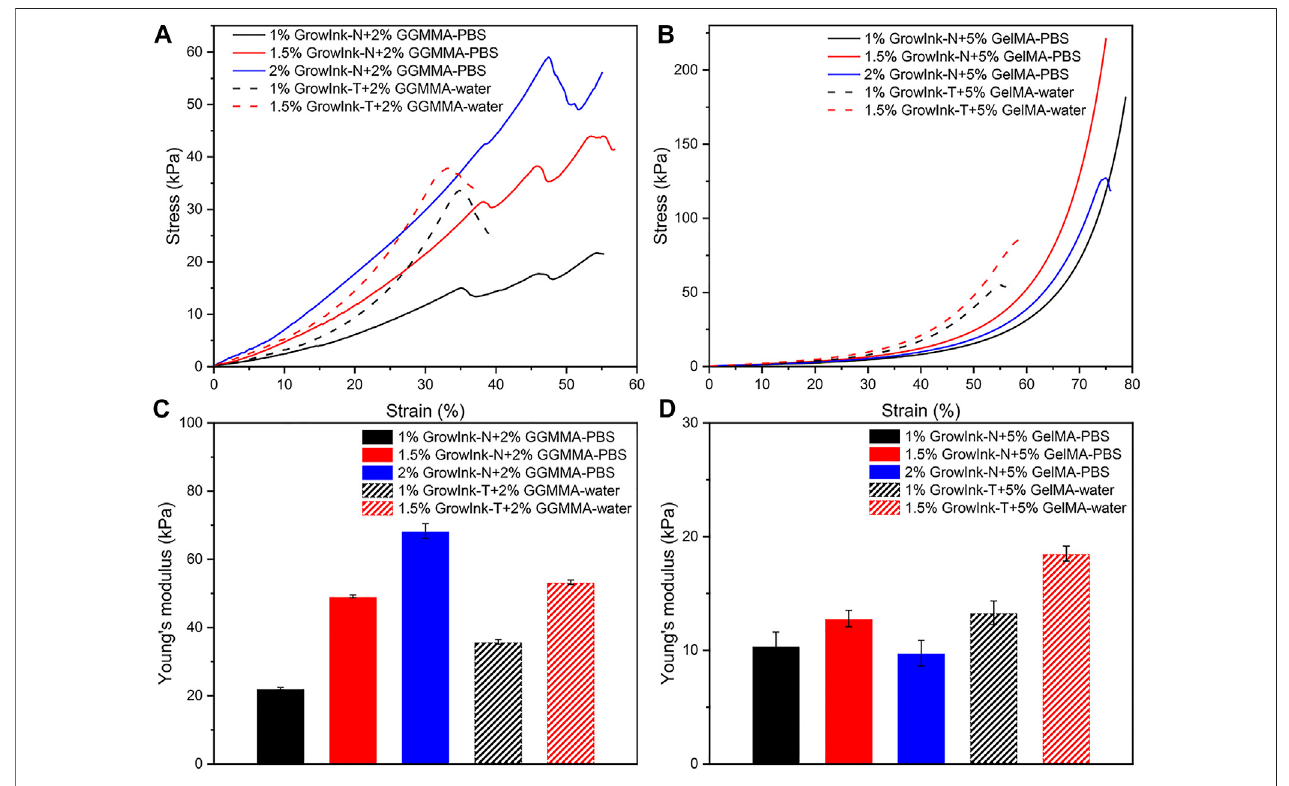
FIGURE 8 | Compressive stress – strain curves and compressive Young ’ s modulus of hydrogels fabricated by GrowInk-N and T with (A and C) GGMMA and (B and D) GelMA.